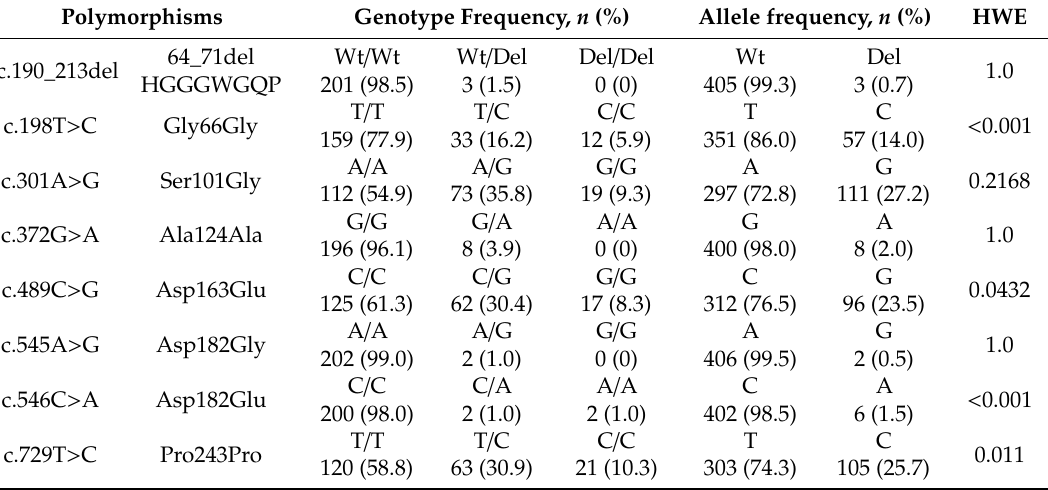
Table 1. Genotype and allele frequencies of the PRNP polymorphisms in